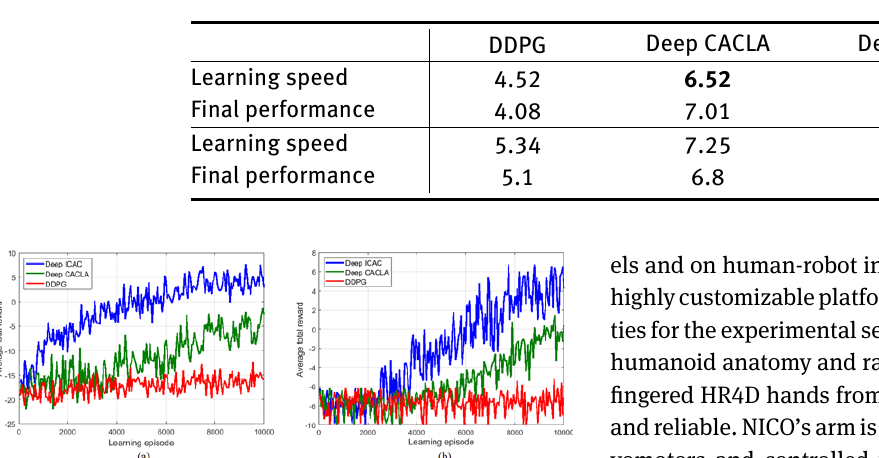
Table 2: Learning statistics in the experiments with dense rewards (upper half) and sparse rewards (lower half).